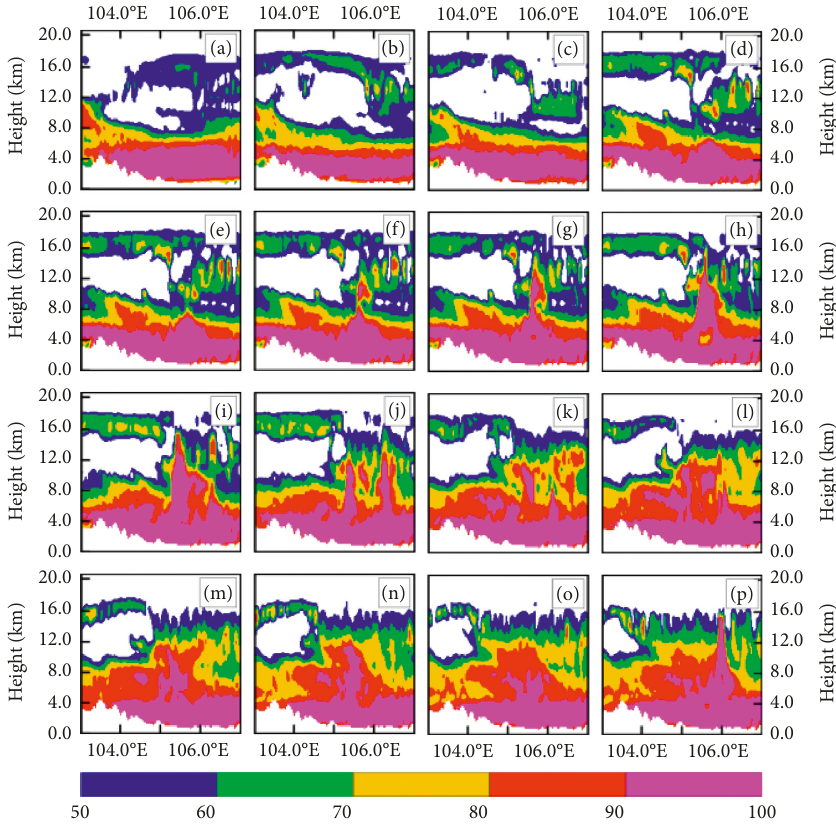
Figure 7: Vertical distribution of relative humidity at 32.1 ° N on June 27: (a) 07:00; (b) 09:00; (c) 11:00; (d) 13:00; (e) 13:10; (f) 13:20; (g) 13:30; (h) 14:00; (i) 15:00; (j) 16:00; (k) 17:00; (l) 18:00; (m) 19:00; (n) 20:00; (o) 21:00; (p) simulated center is at 32.15 ° N and 105.31 ° E. Basically, the simulated rainfall at ground agrees well with the reality in the northeastern Sichuan Basin.